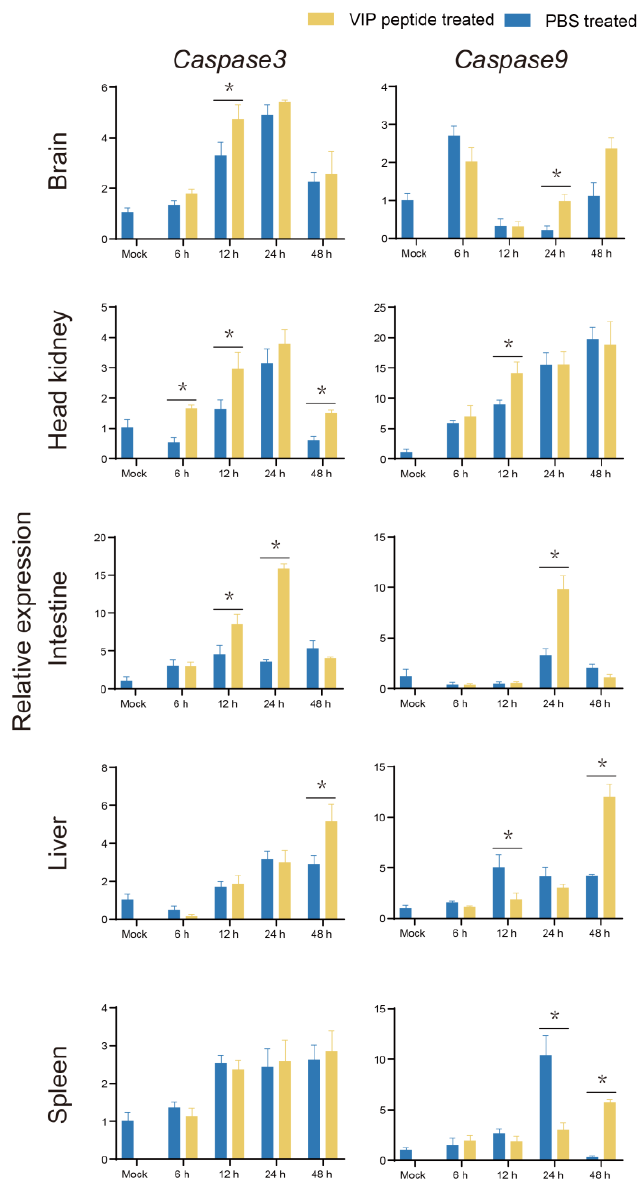
Figure 11. The expression profiles of classic apoptosis factors ( Caspase3 and Caspase9 ) at various points after S. agalactiae infection via qRT-PCR. Every value is presented as the mean and standard deviation; n = 3. The asterisks reveal the significant difference ( p < 0.05).